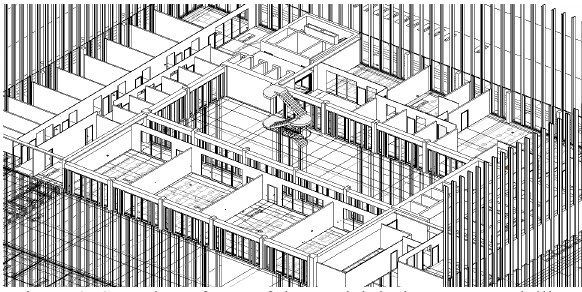
Figure 2. Snapshot of part of the model during BIM modelling workshop in the context of DT